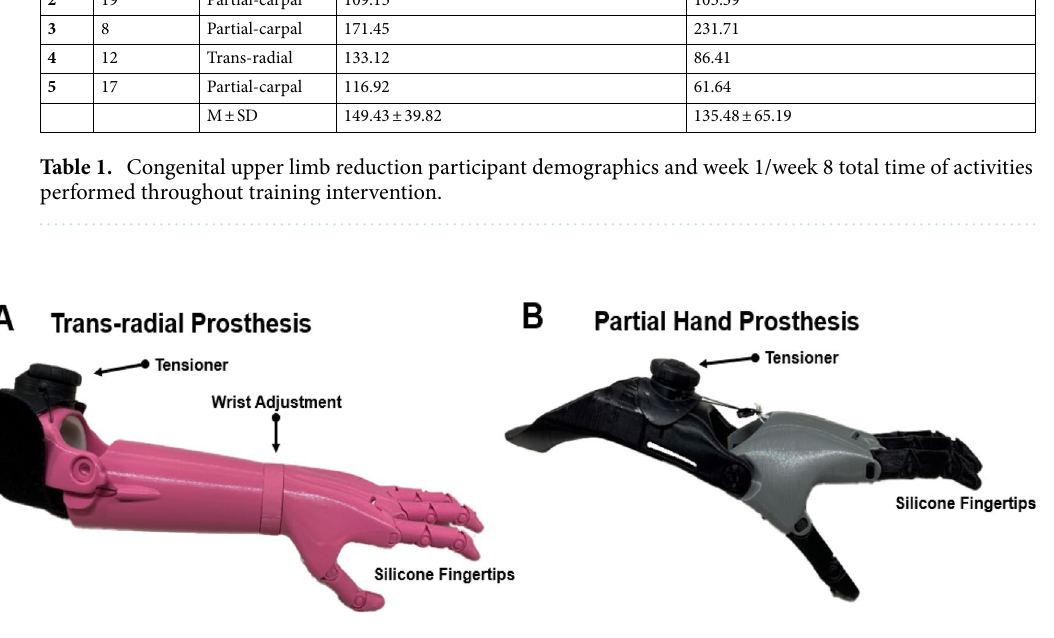
Figure 1. 3D printed prosthesis. Exemplar photo of the ( A) trans-radial prosthesis and ( B) partial hand/carpal prosthesis used in this proof-of-concept study. Elastic cords placed inside the dorsal aspect of the fingers provide passive finger extension. Finger flexion was driven by non-elastic cords along the palmer surface of each finger and was activated through 20° wrist flexion or elbow flexion of the residual functional